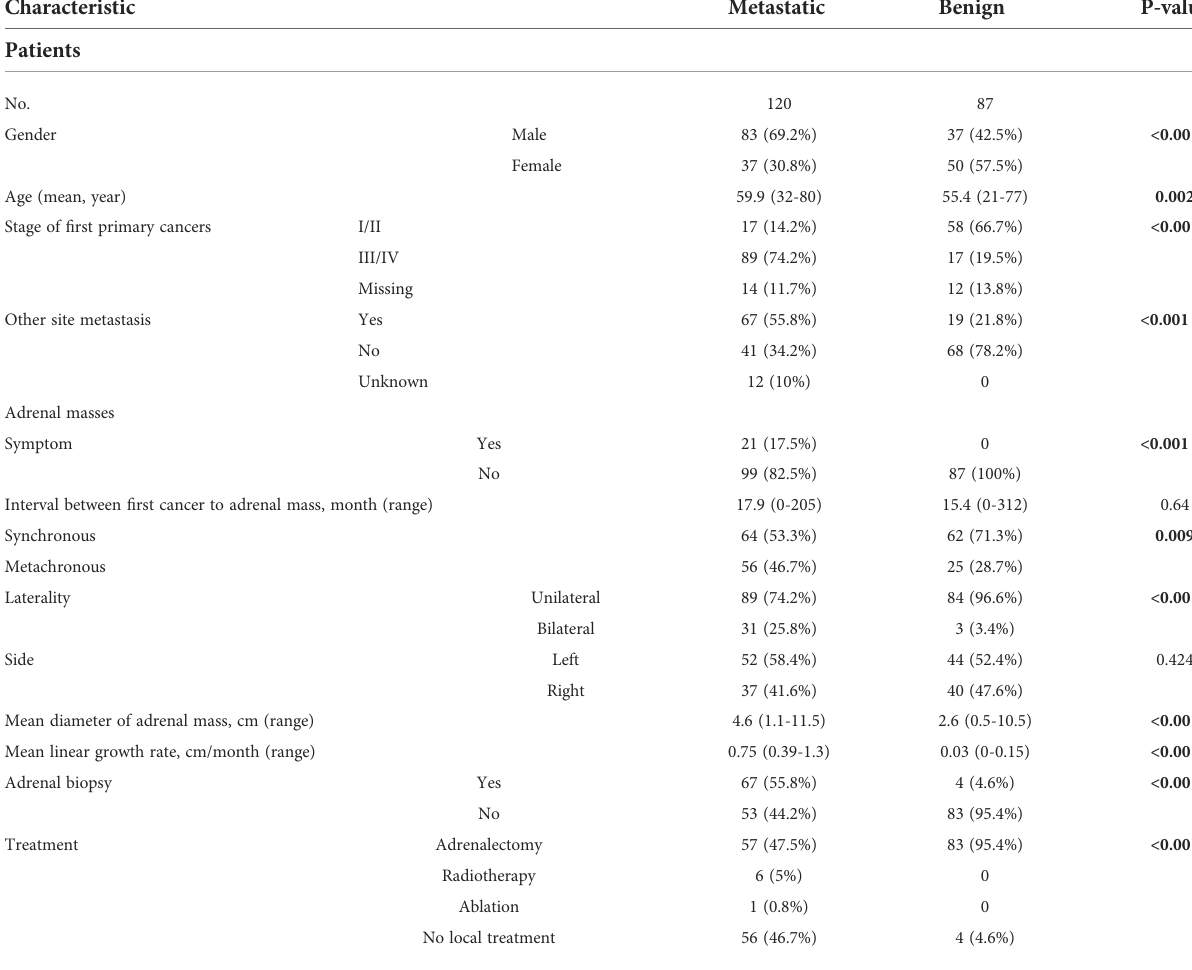
TABLE 2 Demographics and clinical characteristics of patients with adrenal metastases and those with of benign adrenal masses.